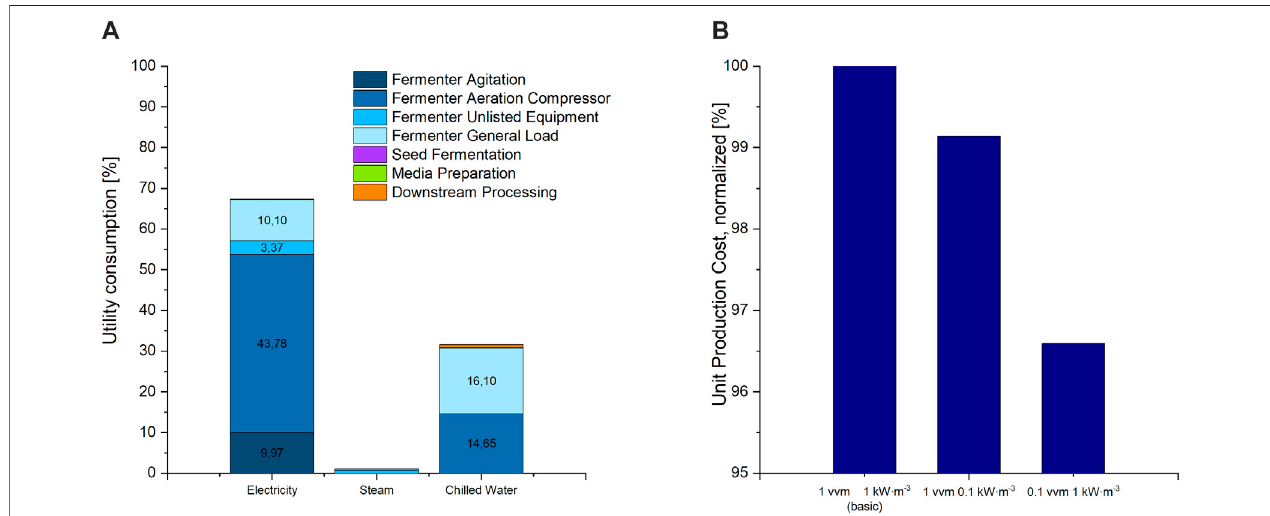
FIGURE 3 | (A) Distribution of utility costs for electricity, steam and chilled water used for cooling amongst all fermentation and puri fi cation units, as percent of overallutilityconsumptioncosts.Sharesbelow3%arenotlabelledinthediagram. (B) UPCofthebasicscenarioatapowerinputof1 kW m 3 foragitationandanaeration rate of 1 vvm compressed air, compared to scenario 11 with 0.1 kW m 3 and scenario 10 with 0.1